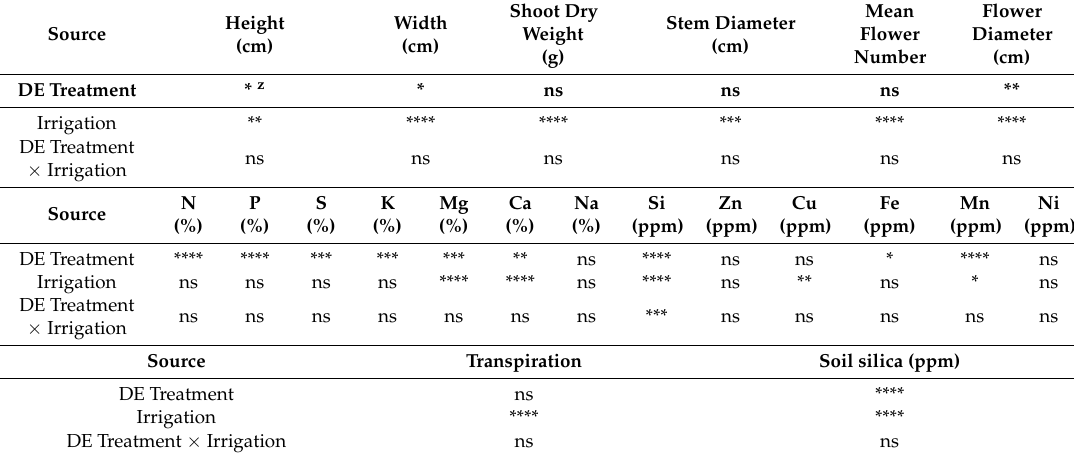
Table 9. Analysis of variance for growth, flowering, leaf nutrient content, soil silica, and physiology of Rudbeckia hirta ‘Denver Daisy’ after application of diatomaceous earth (DE) and irrigation controlled with a